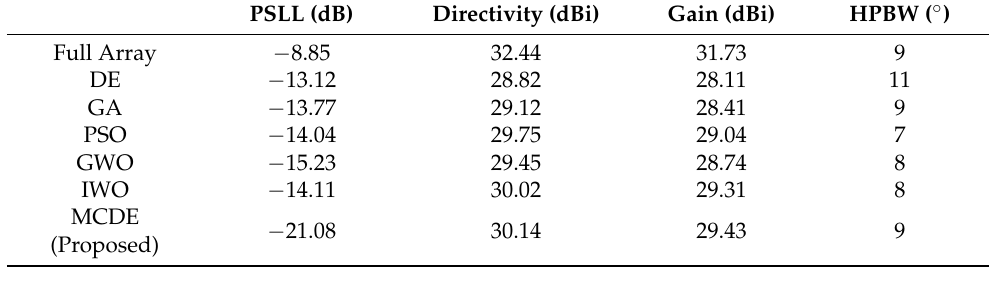
Table 6. The Performances of the Array 2.